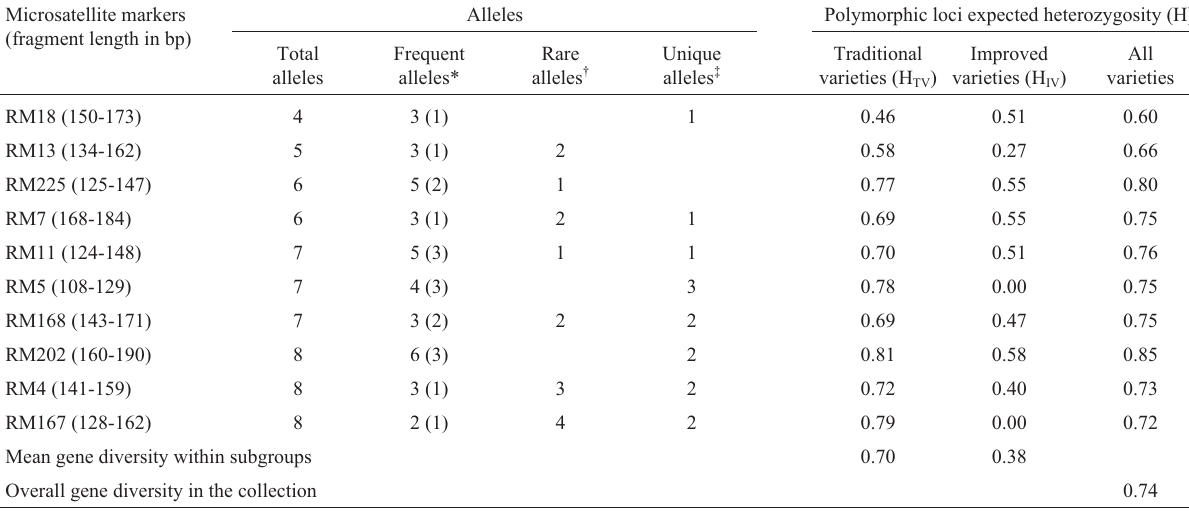
Table 3 - Allele number, allele frequency and heterozygosity of the ten polymorphic microsatellite loci studied. Ordered first by total number of alleles and then by number of frequent alleles. Microsatellite markers (fragment length in